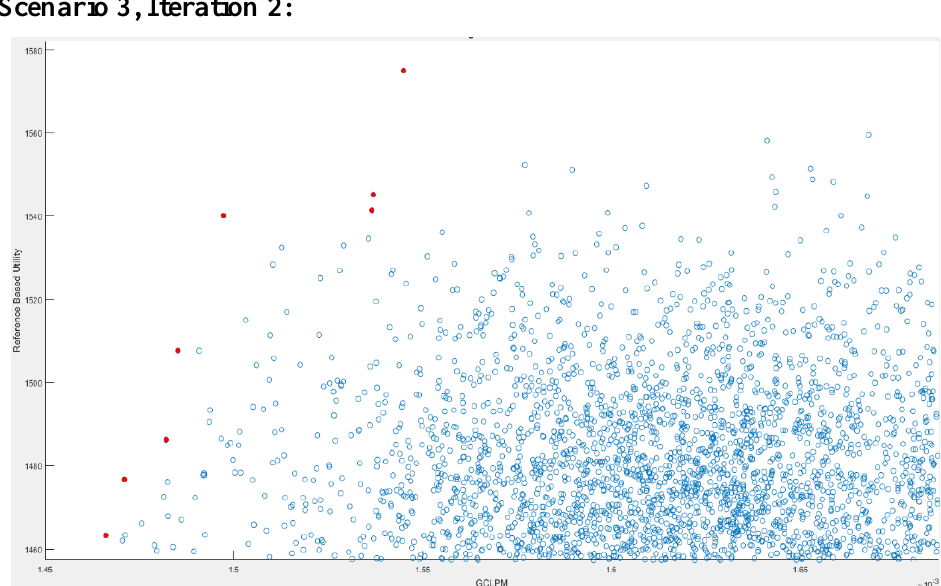
Figure 10. The Result Of Investigation Of 5,000 Different Portfolios In Second Iteration Of Scenario 3